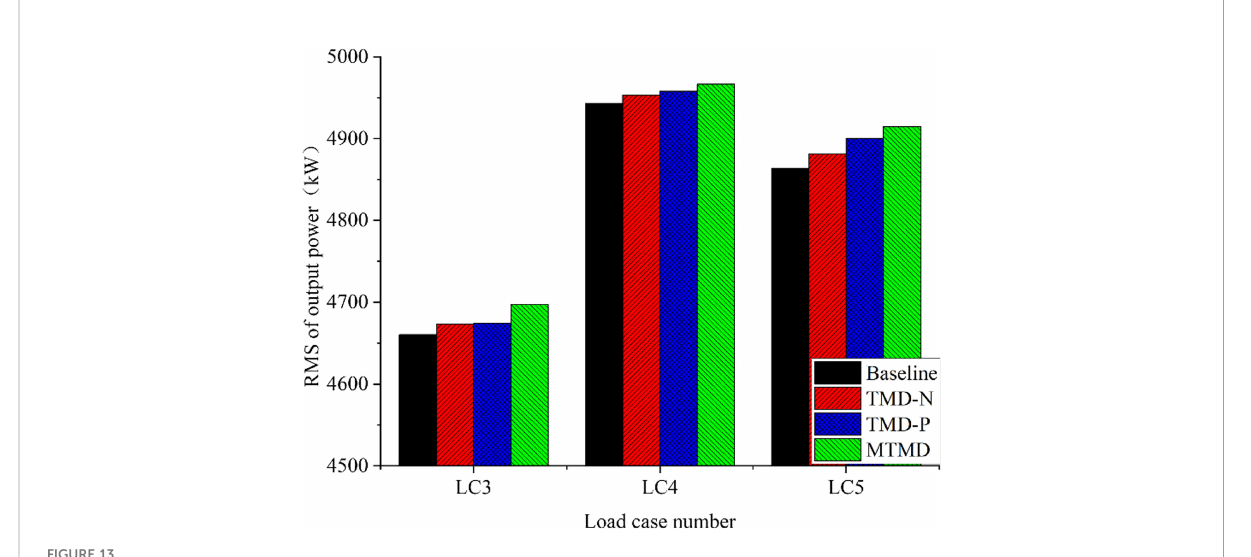
FIGURE 13 Comparison of the RMS value of the output under load cases.